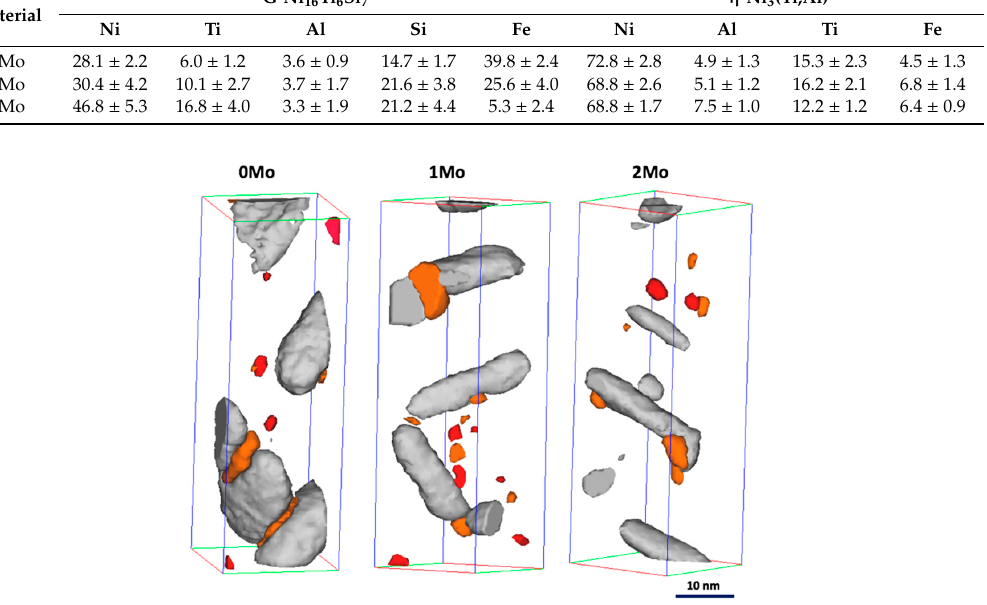
Figure 6. APT reconstructions after aging at 475 °C for 100 h. Cu-rich precipitates are shown in orange, Ni-rich precipitates containing more than 5 at.% Si (G) in red and less than 5 at.% Si ( η ) in grey. Table 4. Composition of the two types of Ni-rich precipitates after aging for 100 h at 475 °C (at.%).